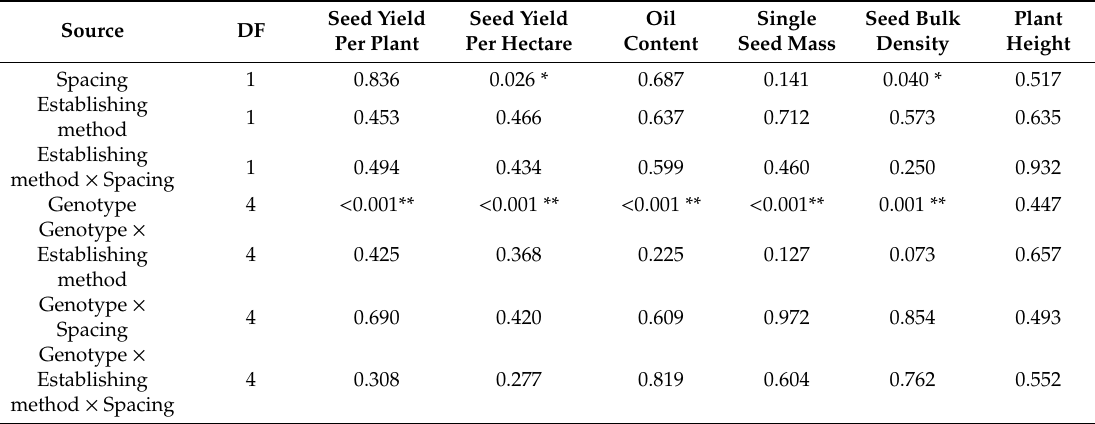
Table 5. P values of e ff ects from analysis of variance at Ihosy (3rd year, DF = degrees of freedom). Source DF